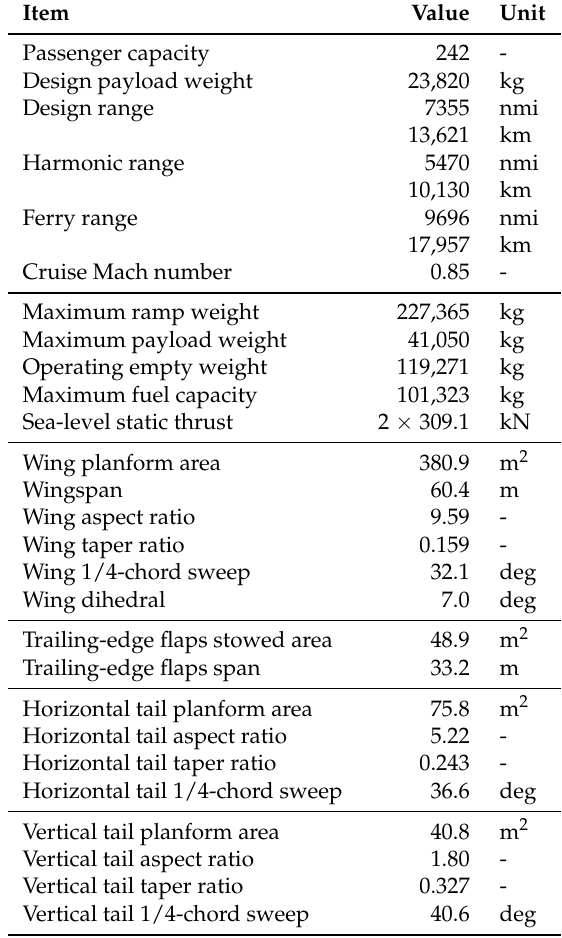
Table 1. Data summary for LTA conventional baseline (this baseline is not equipped with the HLAFC system, and serves as the reference for comparing the AFC-equipped